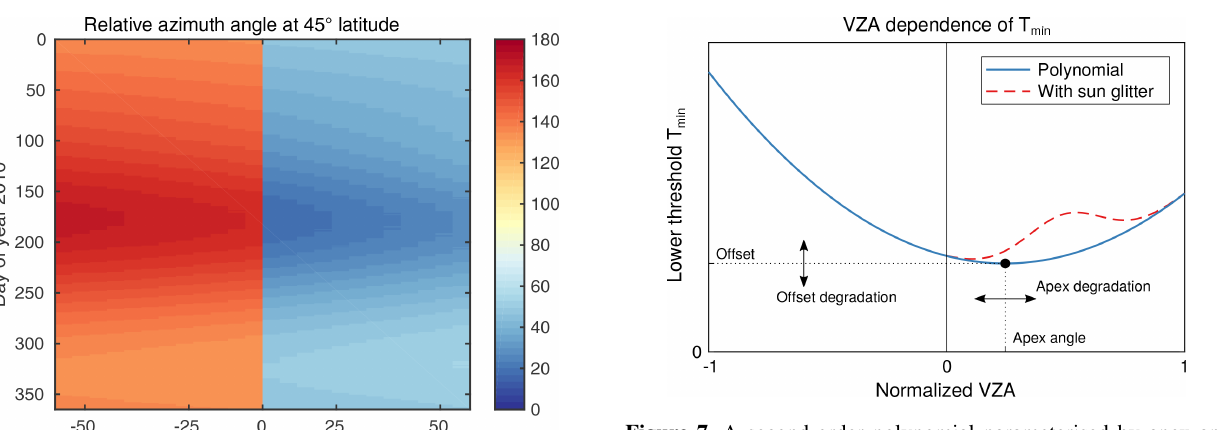
Figure 7. A second-order polynomial parameterised by apex an- gle and curvature model systematic VZA dependencies of the lower threshold T min . Degradation may affect both apex angle and offset. The position, amplitude, and width of the sun glitter contribution depend on geometry and wind